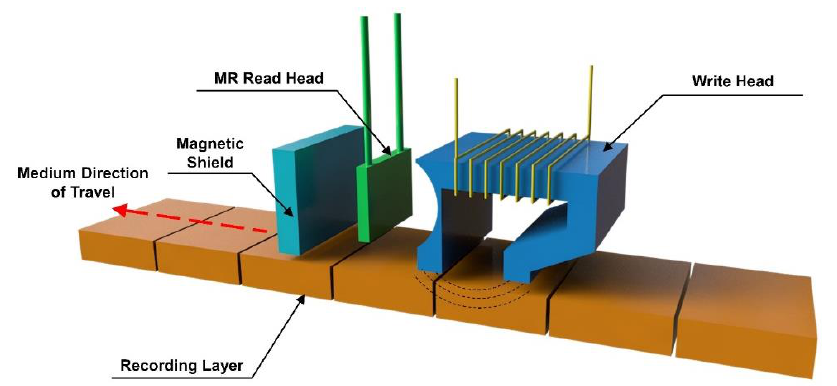
Figure 9. Schematic diagram of the modern read-write head for HDDs. The data bits are displayed in the recording layer.